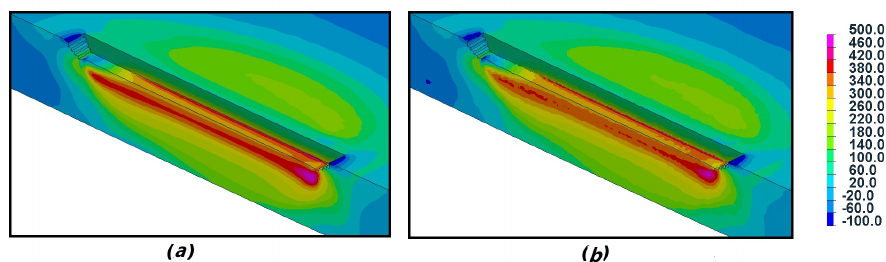
Figure 11. Mean stress distributions—( a ) Mesh A with elements Q1P0, ( b ) nodal approach with smoothed